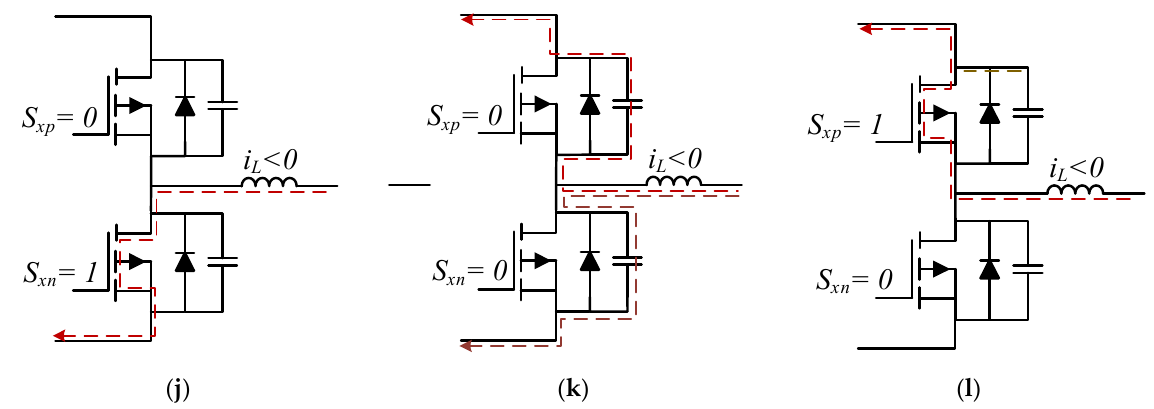
Figure 3. Depiction of the commutation process for an inverter leg with parasitic output capacitances and external SiC Diodes. ( a – c ) Commutation from high side to low side with positive output current. ( d – f ) Commutation from high side to low side with negative output current. ( g – i ) Commutation from low side to high side with positive output current. ( j – l ) Commutation from high side to low side with negative output current.